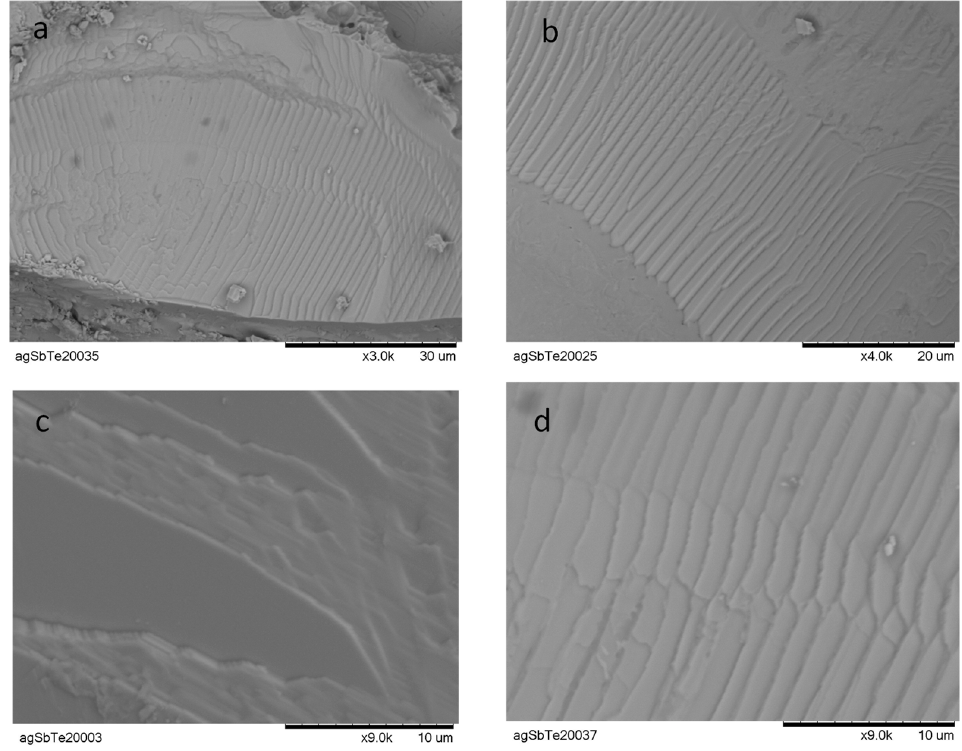
Figure 3. SEM micrographs with ( a ) 3000 × , ( b ) 4000 × , ( c , d ) 9000 × magnification, illustrating the nanostructuration in the layers observed in this material, grown from arc melting.